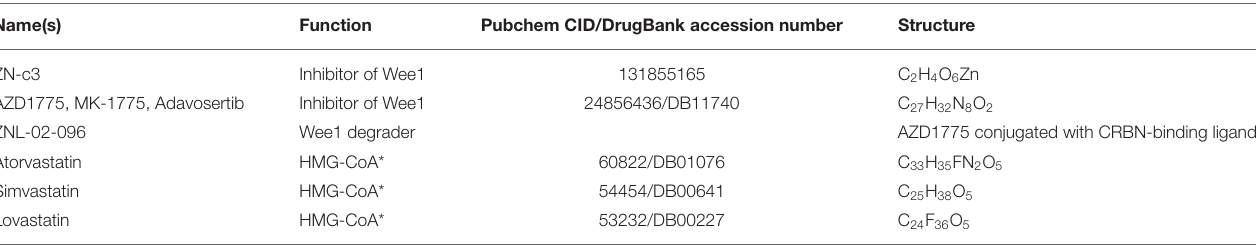
TABLE 1 | Detailed information for Wee 1 inhibitors and